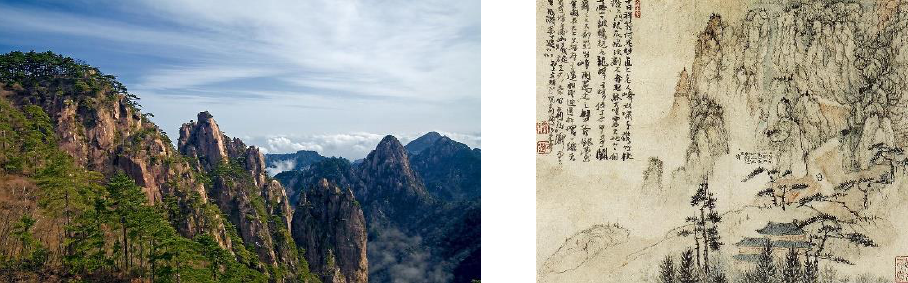
Figure 1. Landscape ( left , Chi King CC BY 2.0 [34]) and ink painting ( right , Shitao 1670 image in the public domain [35]) of Mt.Huangshan.